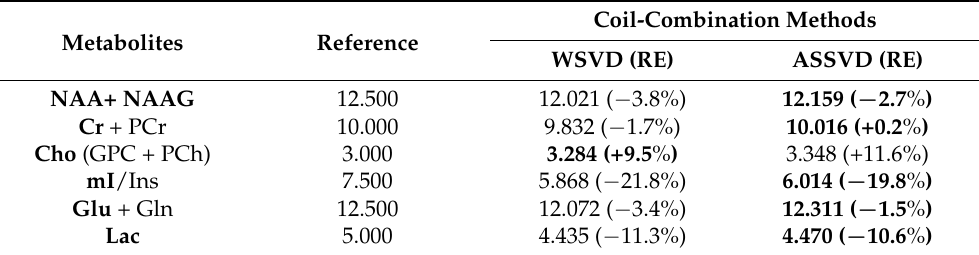
Table 2. Absolute quantification concentration (AQC) (mmol/L) of the phantom experiment. Metabolites